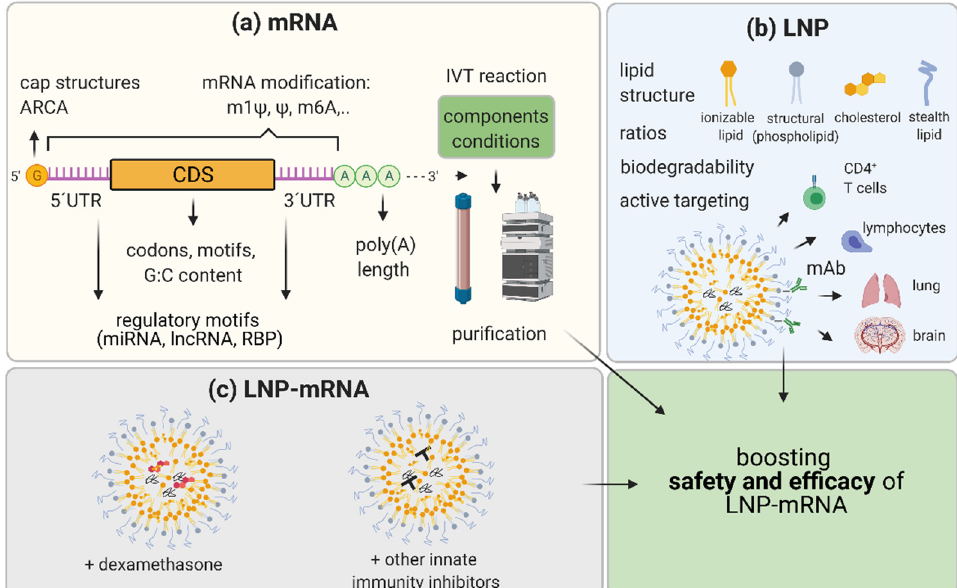
Figure 3. Representation of the strategies to boost efficacy and safety of LNP-mRNA. ( a ) mRNA optimization consists of (1) using different mRNA nucleoside modifications; (2) increasing capping of mRNA by varying cap structures and/or utilizing anti-reverse cap analogues (ARCA); (3) selection of most efficacious UTRs: optimization of 5 ′ UTRs and 3 ′ UTRs by avoiding or exploiting regulatory motifs recognized by micro (mi)RNAs, long non-coding (lnc)RNAs, and RNA binding proteins (RBPs); (4) optimization of the coding sequence (CDS) by using more frequent codons, avoiding specific motifs, and varying G:C content; and (5) varying components and conditions of in vitro transcription (IVT) reaction to decrease byproducts and increase yield, and developing optimal purification protocols for diverse applications. ( b ) Lipid nanoparticle (LNP) optimization may include (1) changing chemistry and molar ratios in between LNP components with a focus on biodegradability and novelty in ionizable lipids and stealth lipids; and (2) the active targeting of other tissues such as using monoclonal antibodies (mAb) recognizing specific molecules on T cells, lymphocytes, and brain or lung vasculature. ( c ) Moreover, to achieve increased efficacy and maximal safety, co-formulating molecules as corticosteroids (dexamethasone) or other small molecules known to inhibit innate immunity with LNP-mRNA candidate therapeutics may be performed. Optimization of the mRNA and LNP as components and combining LNP-mRNA with immune inhibitors aim to boost safety and efficacy of LNP-mRNA drug candidates. Created with